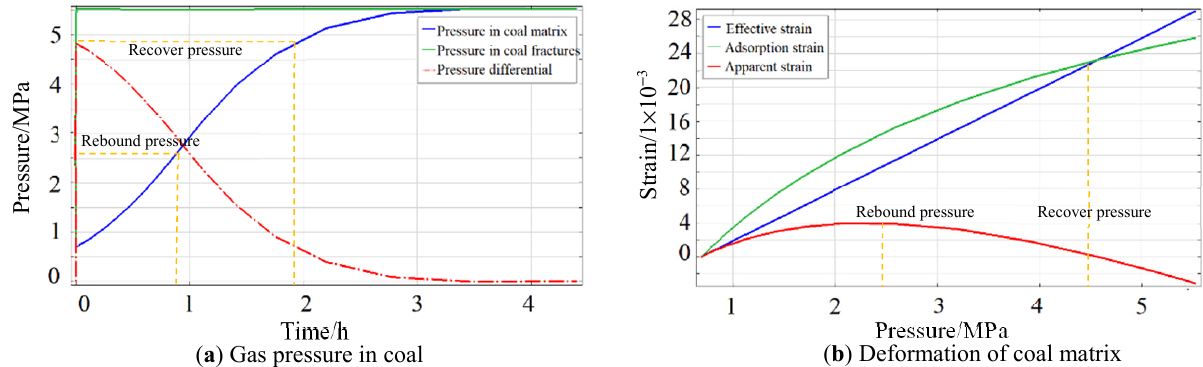
Figure 8. Change of gas pressure and coal matrix deformation.